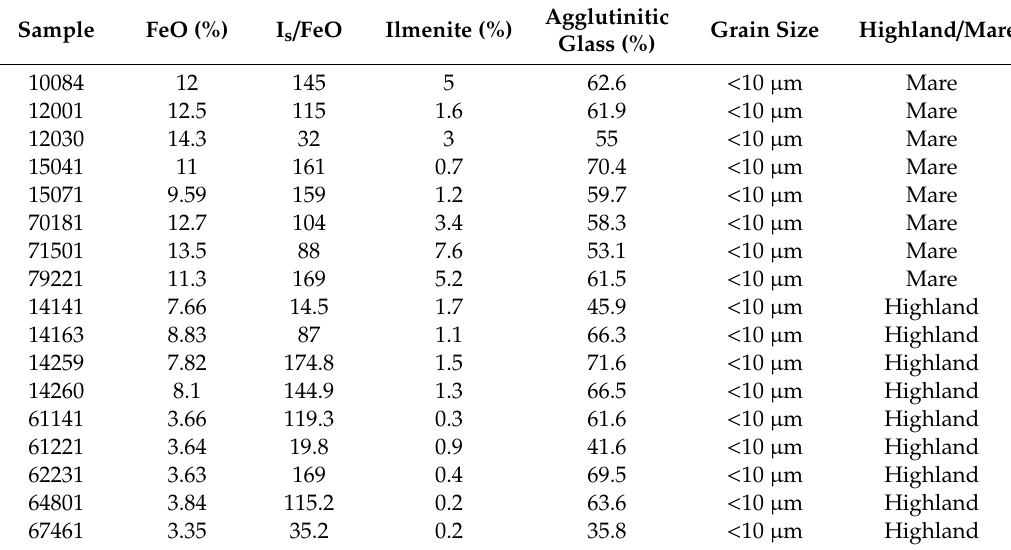
Table 1. Lunar Soil Characterization Consortium (LSCC) dataset used in this